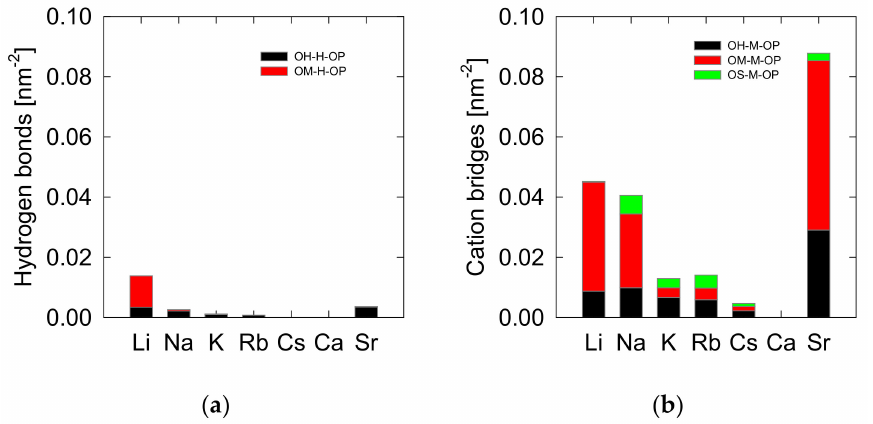
Figure 7. Spodumene-oleate interactions in salt solutions, ( a ) hydrogen bonds and ( b ) cation bridges.